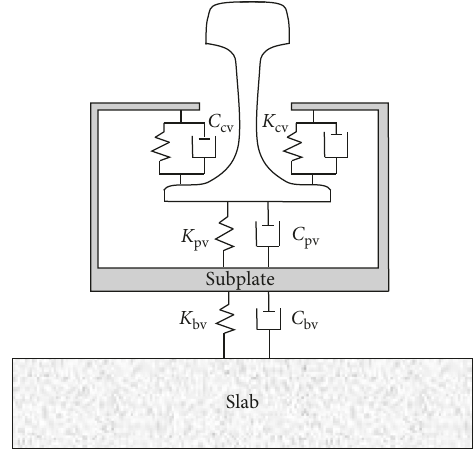
Figure 3: Spring dashpot representation of the fastening